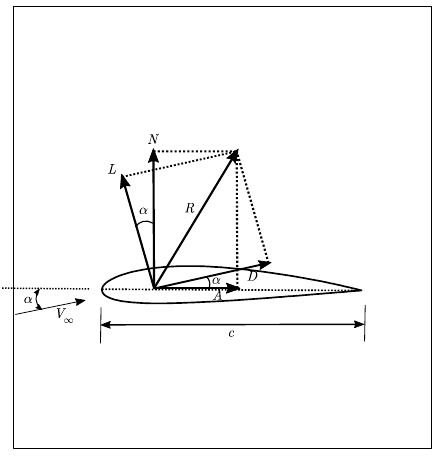
Figure 8. Aerodynamic force R and the components into which it splits [4]. Fluids 2019 , 4 , x